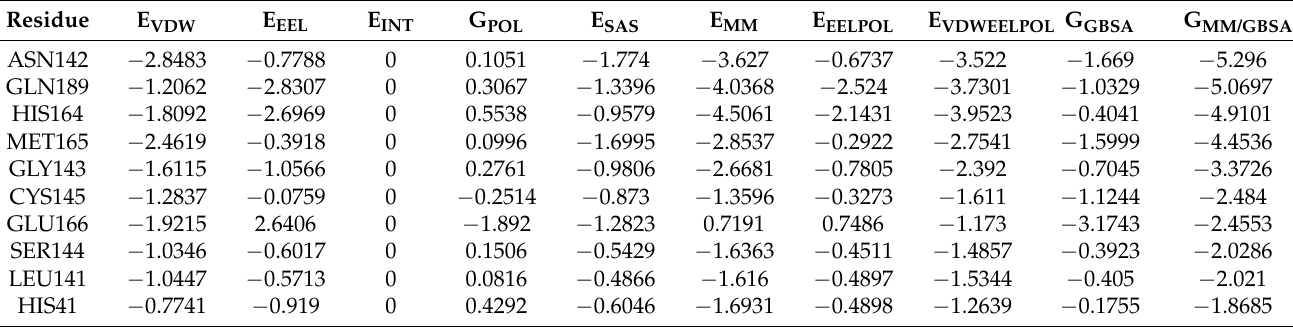
Table 5. Energy decomposition of MM/GBSA free energy for the ZINC12530139. All energies are in